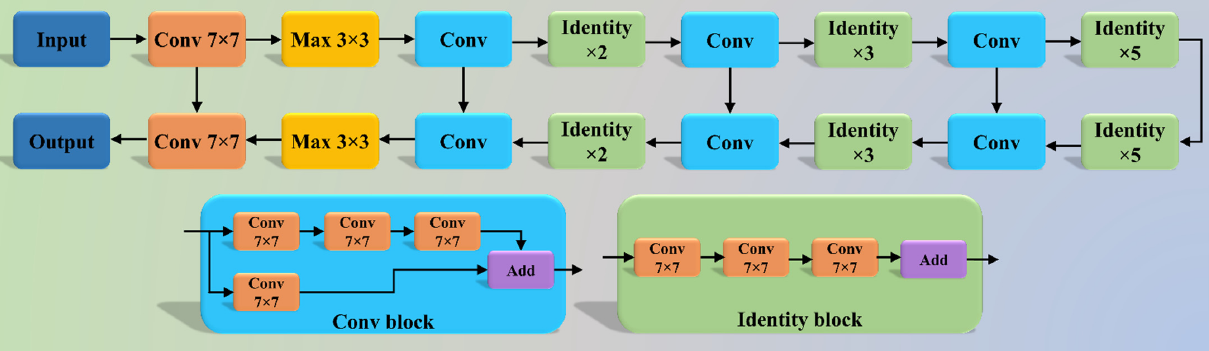
Figure 6. ResNet-SegNet architecture.